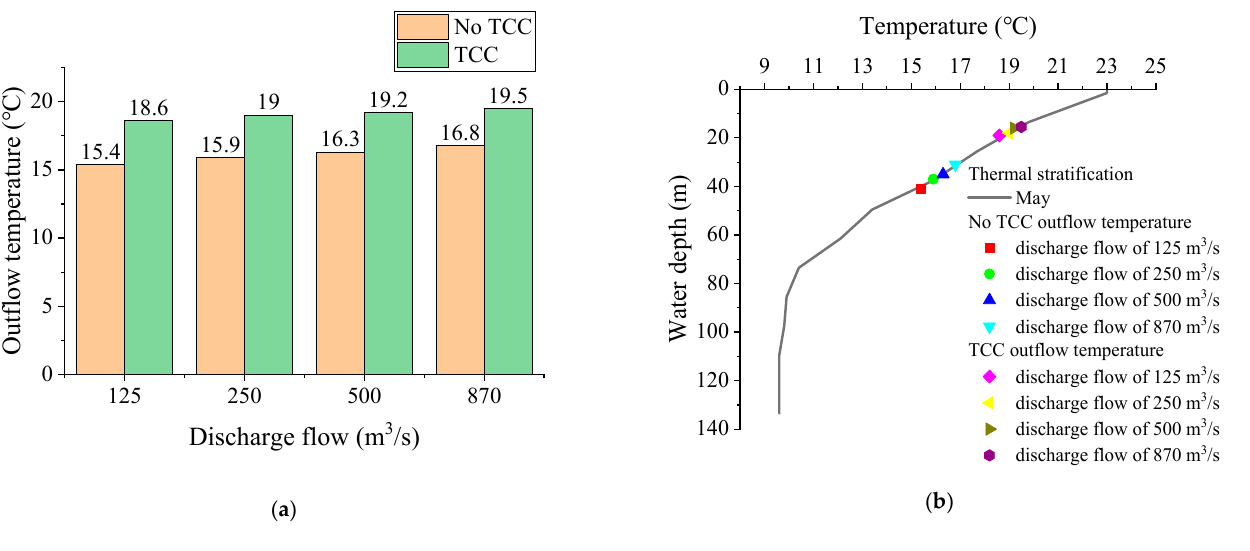
Figure 13. Comparison of outflow temperature: ( a ) before and after TCC implementation; ( b ) different discharge